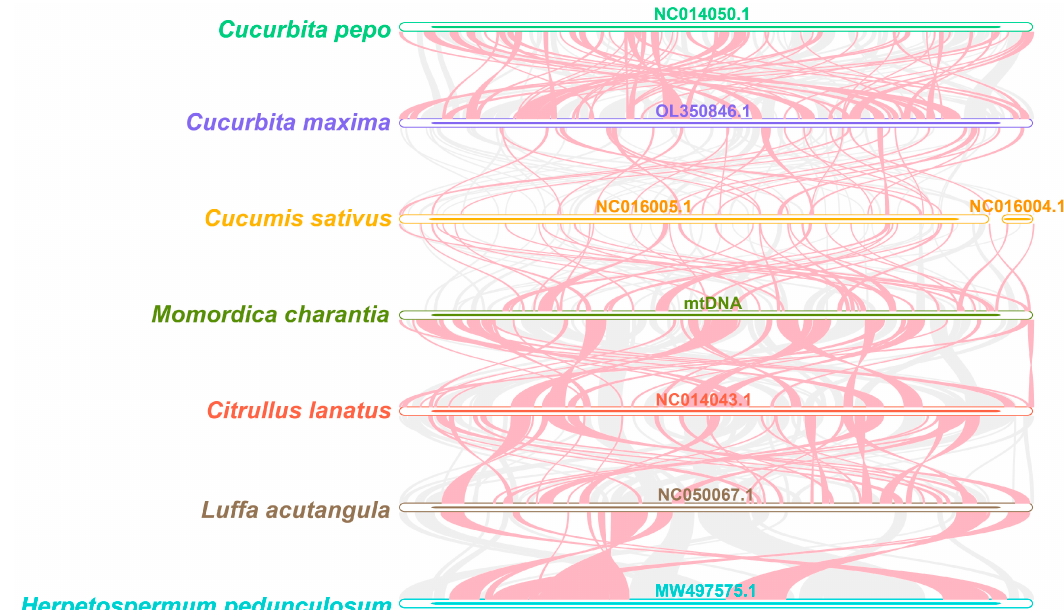
Figure 7. Covariance analysis. The red curved areas indicate regions where inversions occur, and the gray areas indicate regions with good